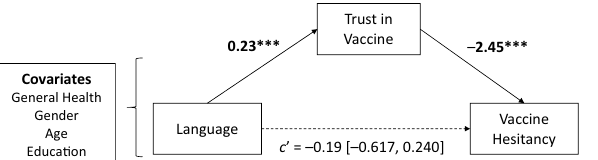
Figure 2. Language effect on vaccine hesitancy explained by trust in the COVID-19 vaccine. Mediation coefficients represent unstandardized coefficients (95% CI in